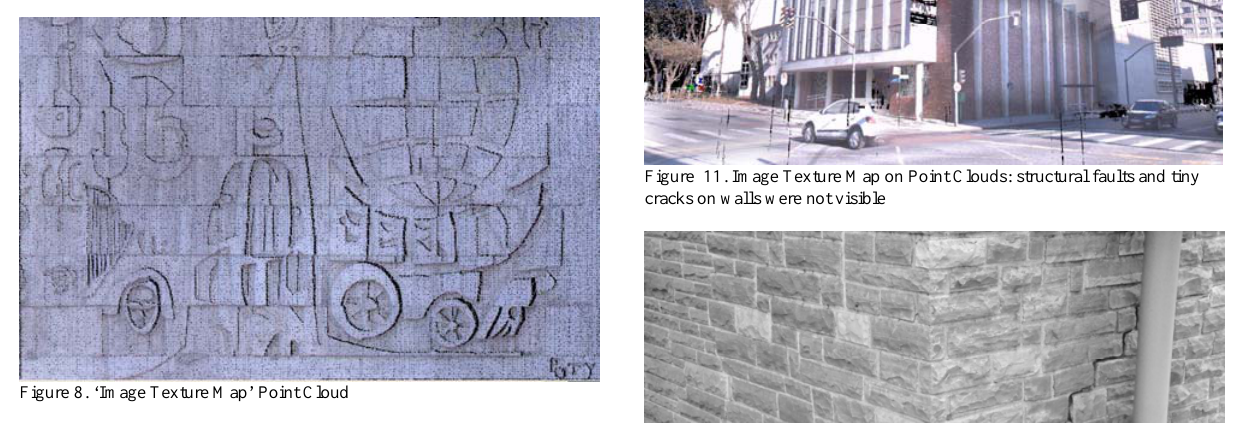
Figure 9. Poor details visualization when zooming into a ‘Colours from Scanner’ Point Cloud